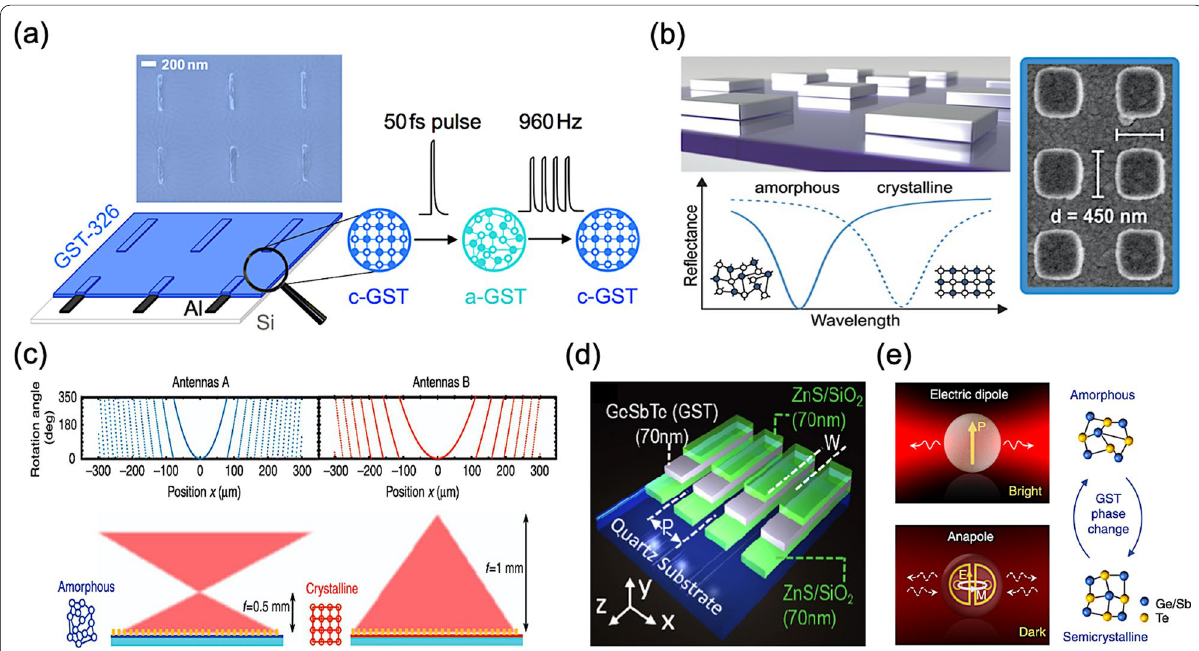
Fig. 4 Thermally reconfigurable and tunable metasurfaces with GST a Reversible metasurface with nanoantennas controlled by femtosecond laser pulses [72], b Switchable perfect absorber meta‑device with nanoantennas stacked above phase change material [73], c Cylindrical bifocal metalens for amorphous and crystalline GST [74], d Structures of a nanograting metasurface for dielectric‑plasmonic transitions [75], and e Electric dipole resonance and an anapole excitation in a GST sphere introduced by an intermediate phase transition